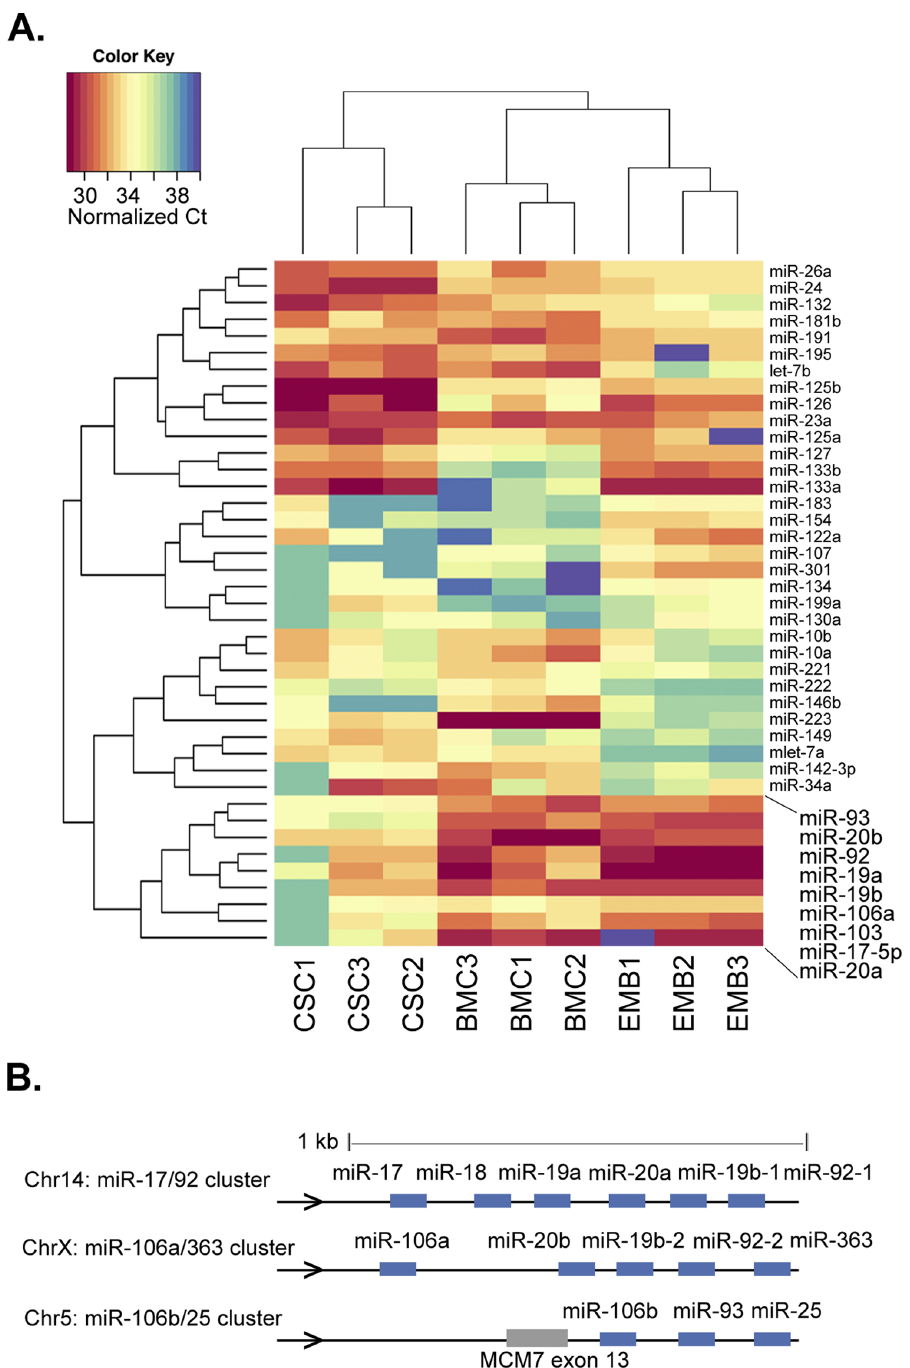
Figure 1. Comparative miR expression in progenitor cell populations with cardiogenic potential. A. Hierarchical clustering for samples and miRs of three independent replicates of mouse CSCs (CSC), adult BMCs isolated from mouse bone marrow (BM) and mouse embryonic heart day E9 (EMB). Box highlights the miR branch separating CSCs from BMCs and embryonic heart cells, composed almost exclusively of miR-17/92 family members. Data shown refers to normalized Ct values (color key) of filtered subset of 41 differentially expressed miRs, out of the 95 miRs analyzed (see methods). B. The mouse miR-17/92 family loci. Expression levels for all members of this cluster were determined, with the exception of miR-363, which was not present in the PCR array used in this